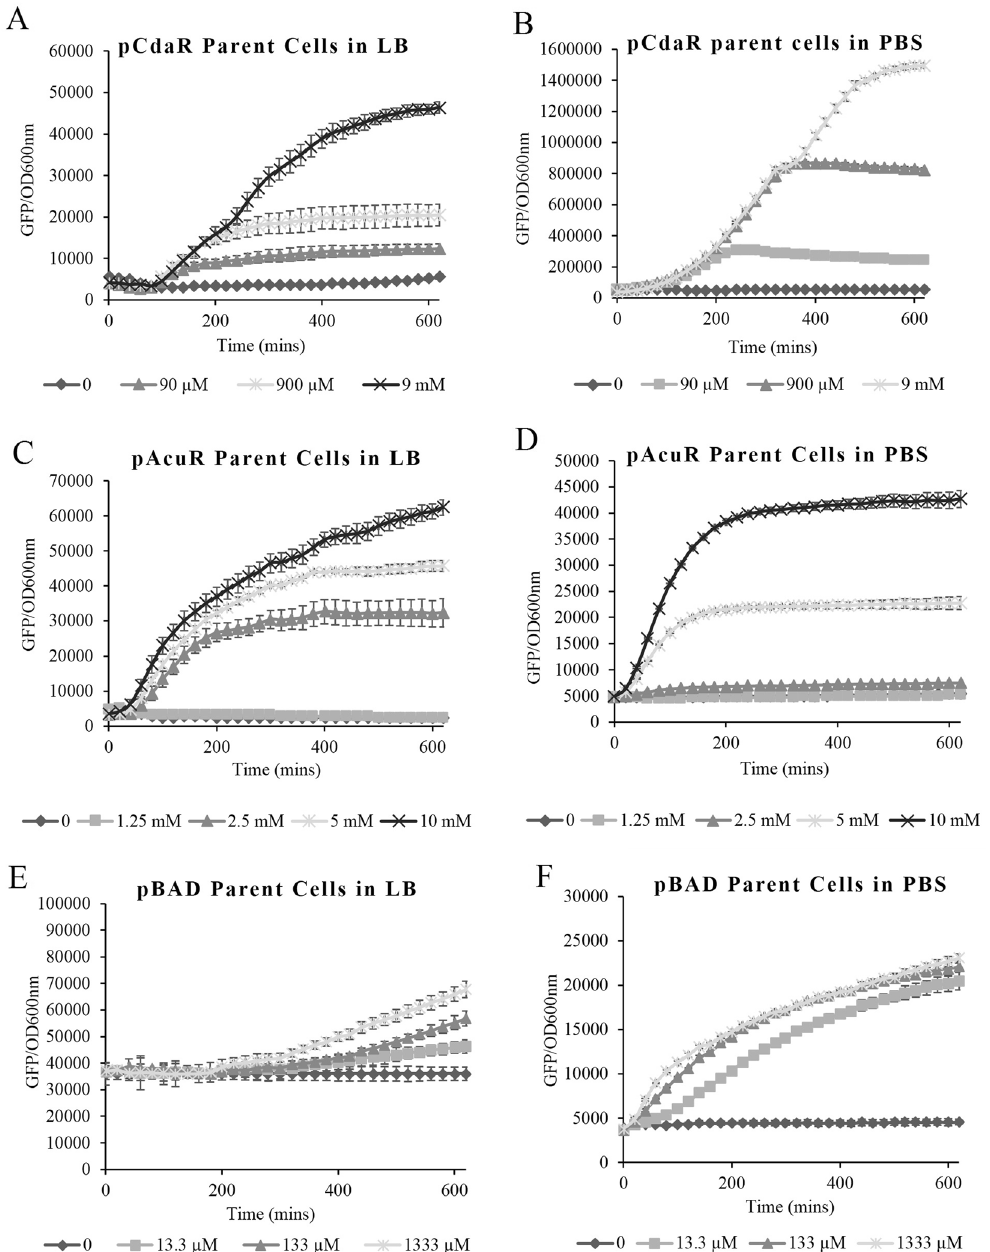
Figure 2. Induction of parent cells in LB and PBS over time, as determined by GFP fluorescence per unit OD at 600 nm (n = 4). Error bars denote one standard deviation above and below the mean. pCdaR parent cells induced by glucarate in LB ( A ) and PBS ( B ), pAcuR parent cells induced by acrylate in LB ( C ) and PBS ( D ), and pBAD parent cells induced by arabinose in LB ( E ) and PBS ( F ). The OD 600 nm curves for the parent cells induced in PBS are shown in Fig.